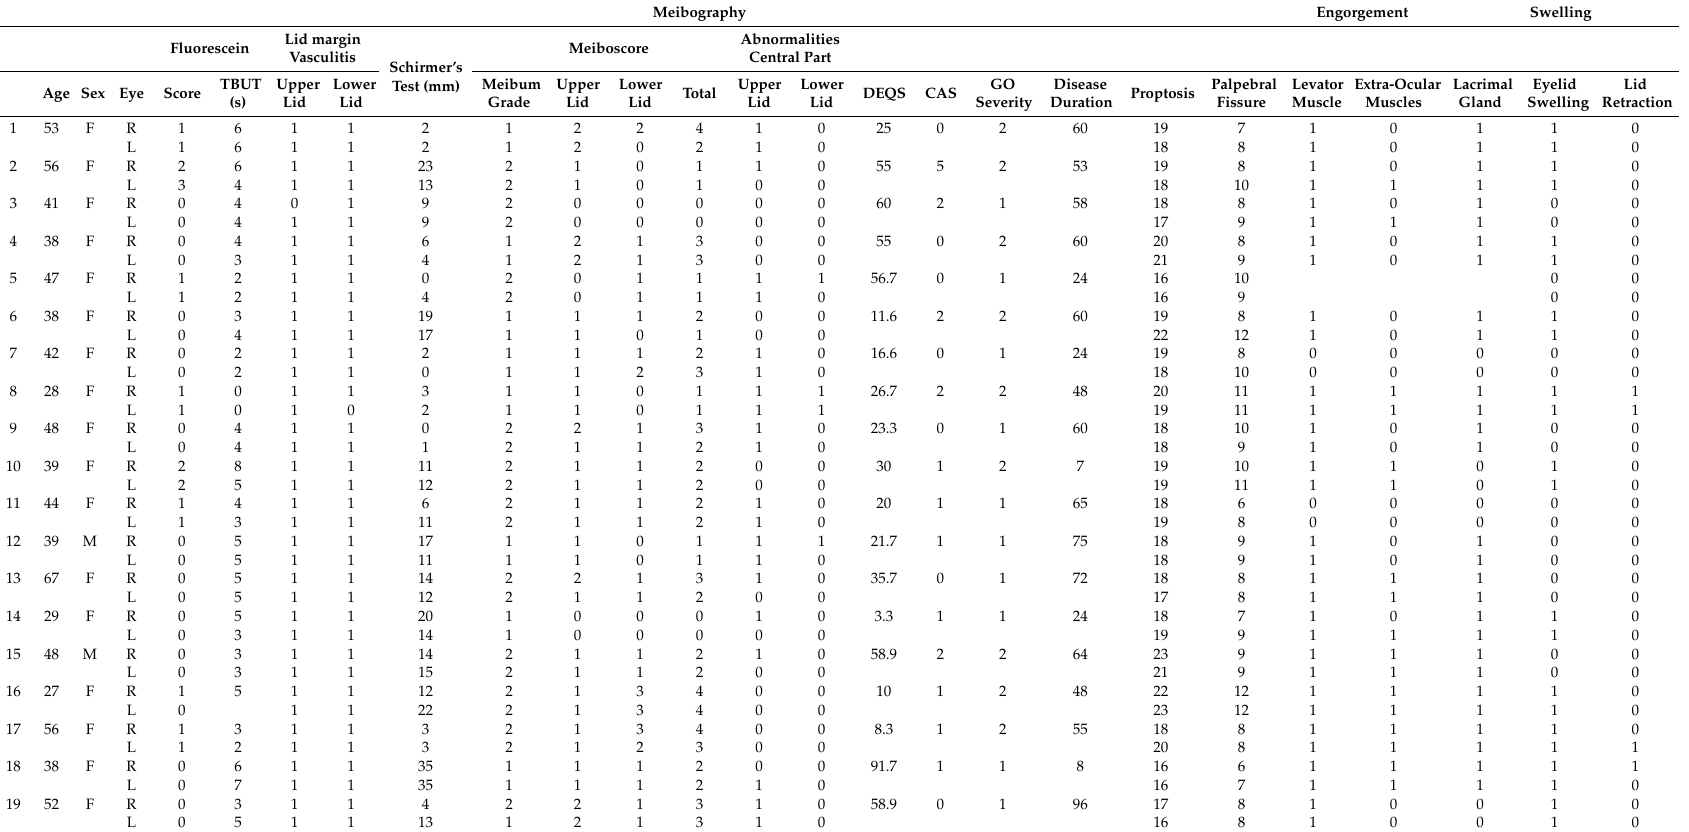
Table 3. Ocular surface parameters and Graves’ ophthalmopathy (GO)